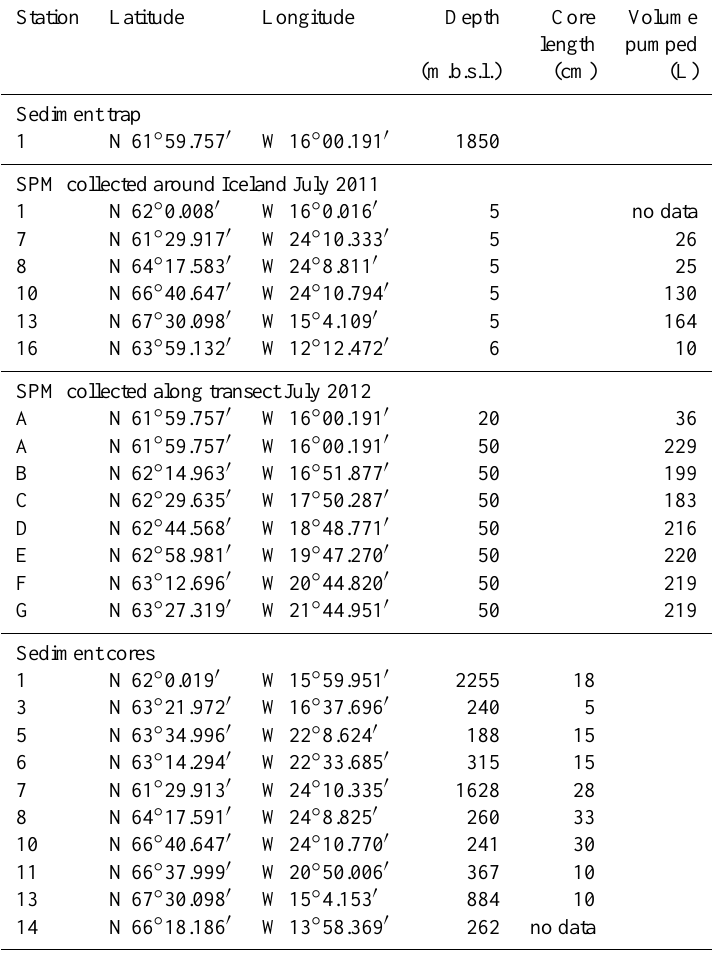
Table 1. Location, depth and other information on each material collected at different stations around Iceland. Station Latitude Longitude Depth Core Volume length pumped (m.b.s.l.) (cm)